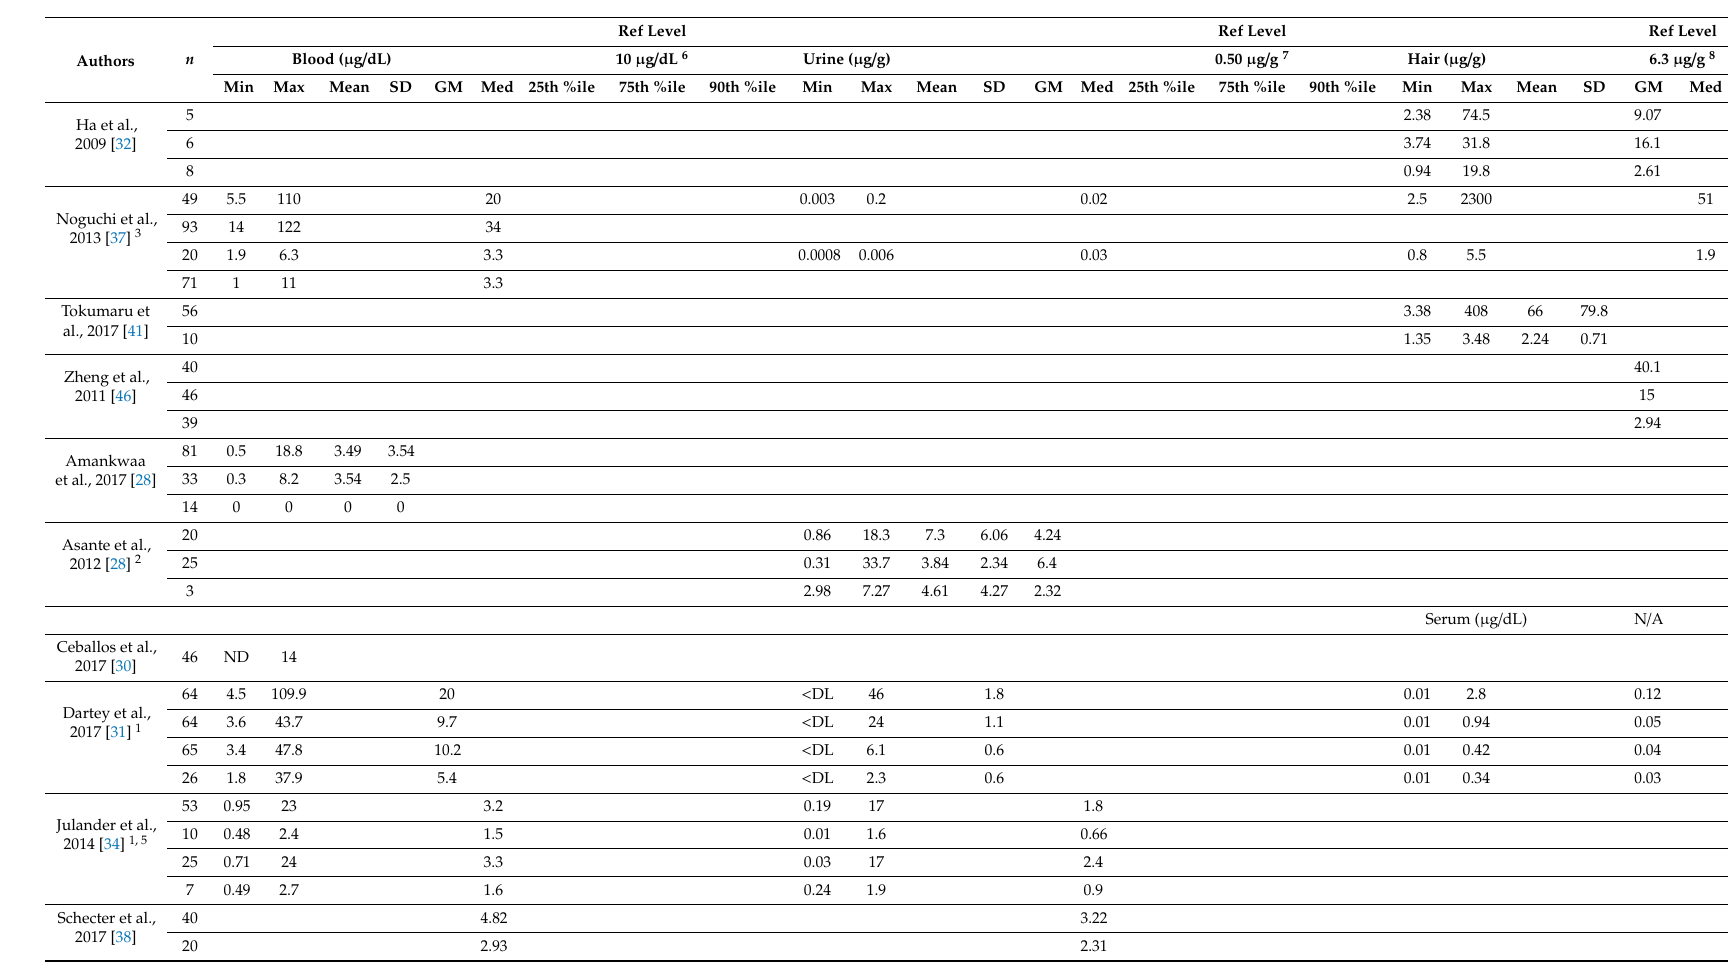
Table 4. Results of data extraction from a study set for Pb biomarkers in blood, serum, plasma, urine, and